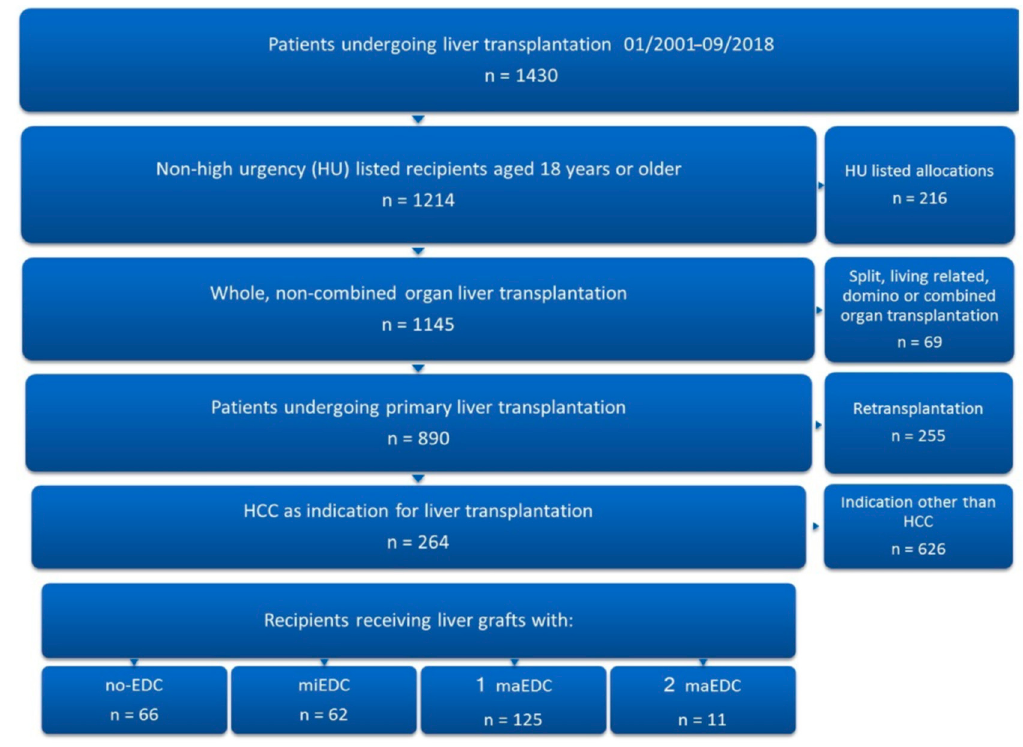
Figure 1. Patient selection. Of 1430 patients who underwent liver transplantation at our institution from